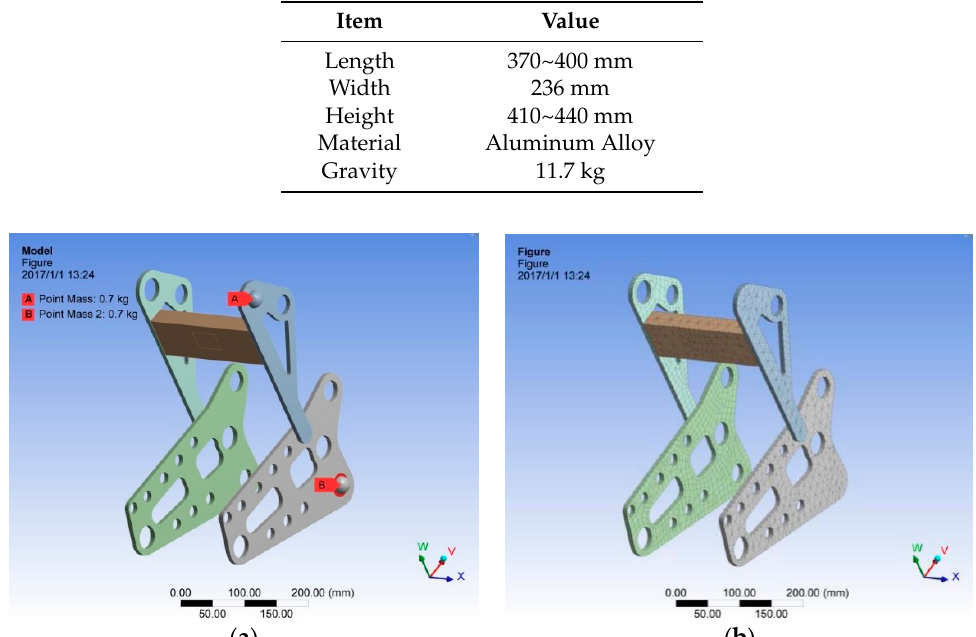
Figure 9. Finite element analysis of the robot. ( a ) Finite element model of the robot; ( b ) Finite element mesh.